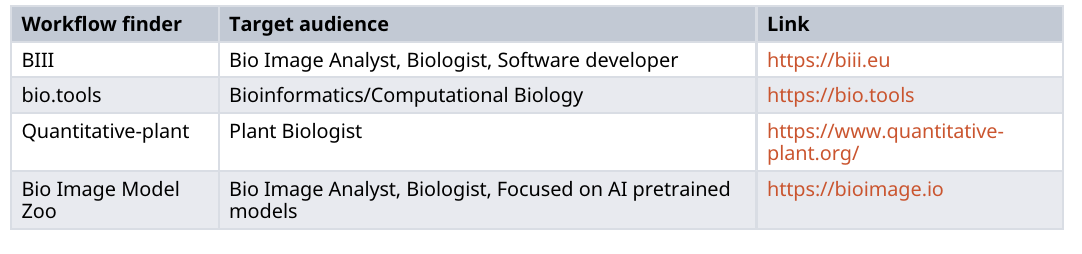
Table 1. Workflow finder. Some examples of such databases where bioimage analysts can reference their workflows.